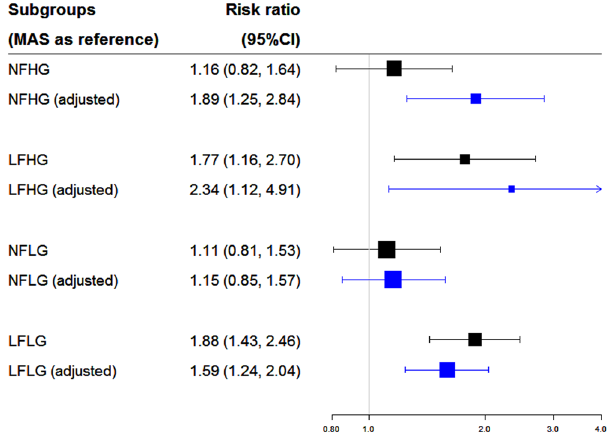
Figure 5. Effects of AVR on the different flow-gradient states of severe aortic stenosis.